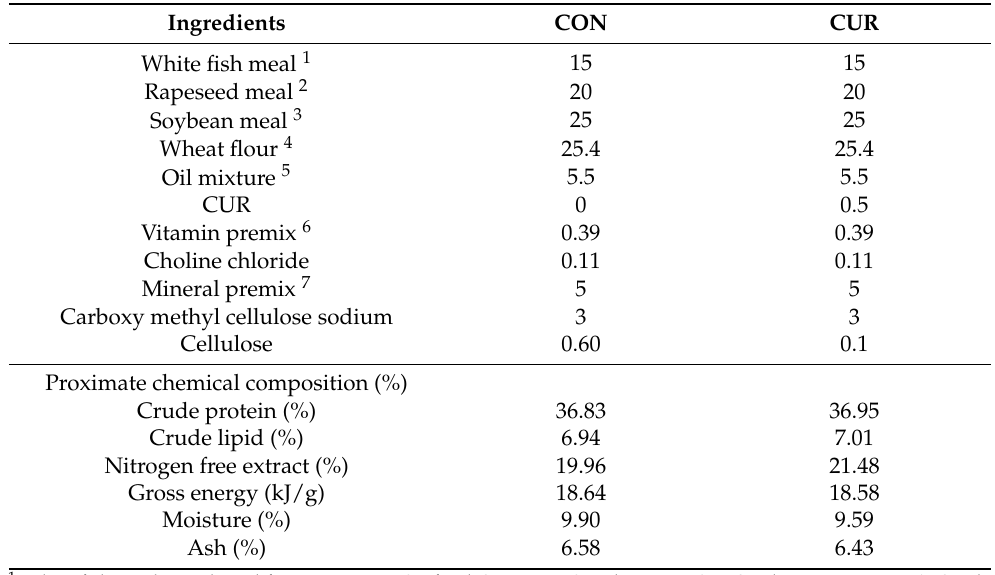
Table 2. Formulation and approximate composition (% dry matter) of practical diets supplemented with curcumin